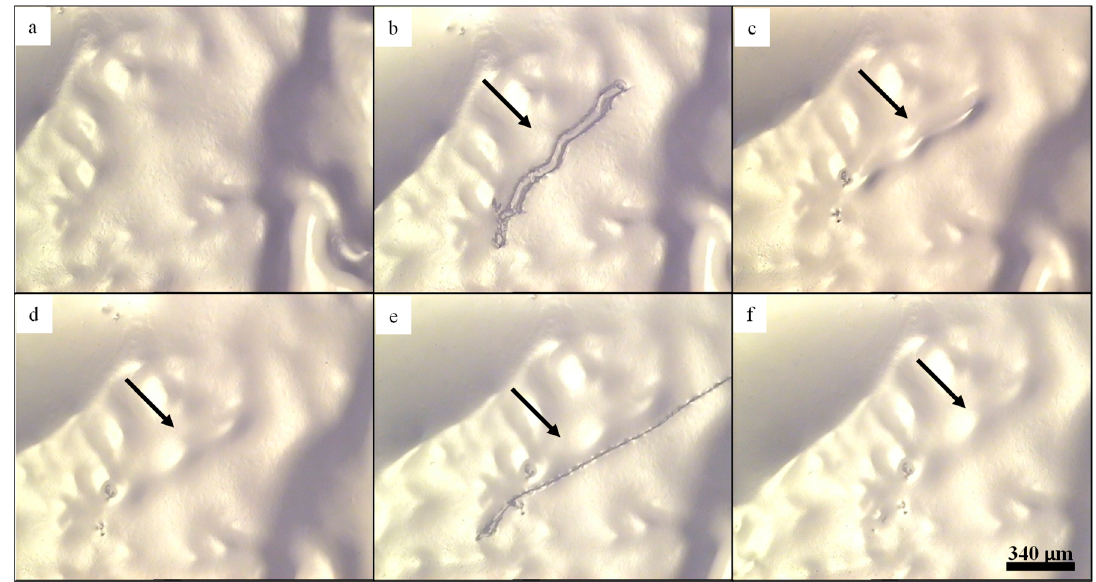
Figure 5. Healing of histidine ‐ containing polymers. ( a ) Into a film of the histidine ‐ based supramolecular polymer network, ( b ) a scratch was introduced and ( c ) healed for 40 h at 100 °C. ( d – f ) This procedure was repeated once with healing for 19 h at 100 °C. Reprinted from [102], Copyright 2015, with permission from Elsevier.